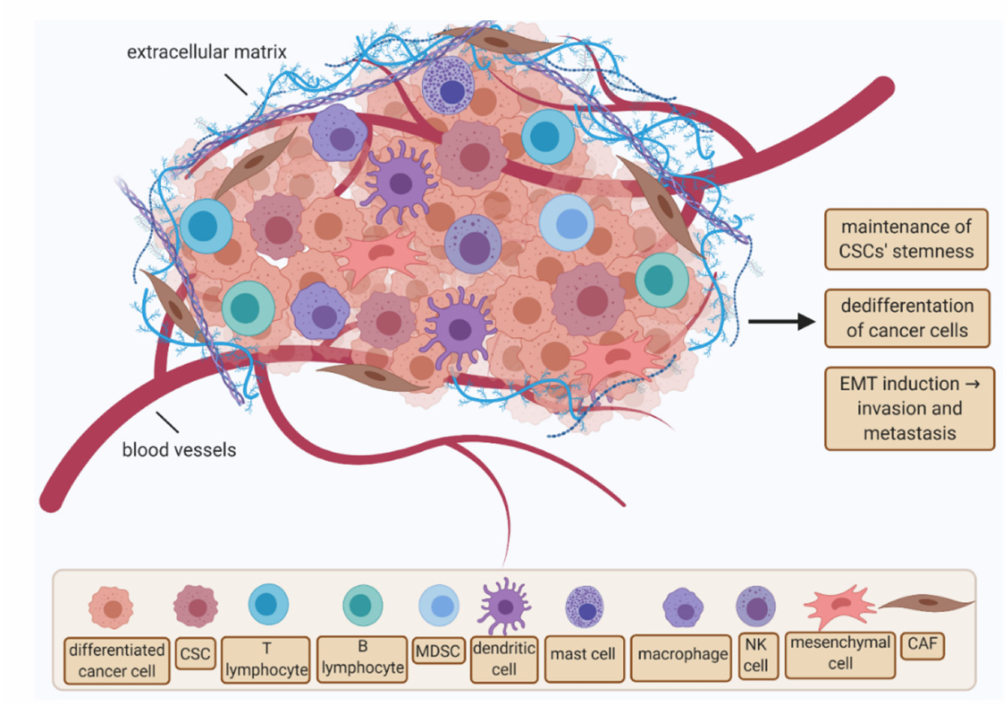
Figure 1. Cancer stem cells’ microenvironment—niche. Abbreviations: CAF—cancer-associated fibroblast; EMT—epithelial- to-mesenchymal transition; CSC—cancer stem cell; MDSC—myeloid-derived suppressor cell; NK cell—natural killer cell (created with